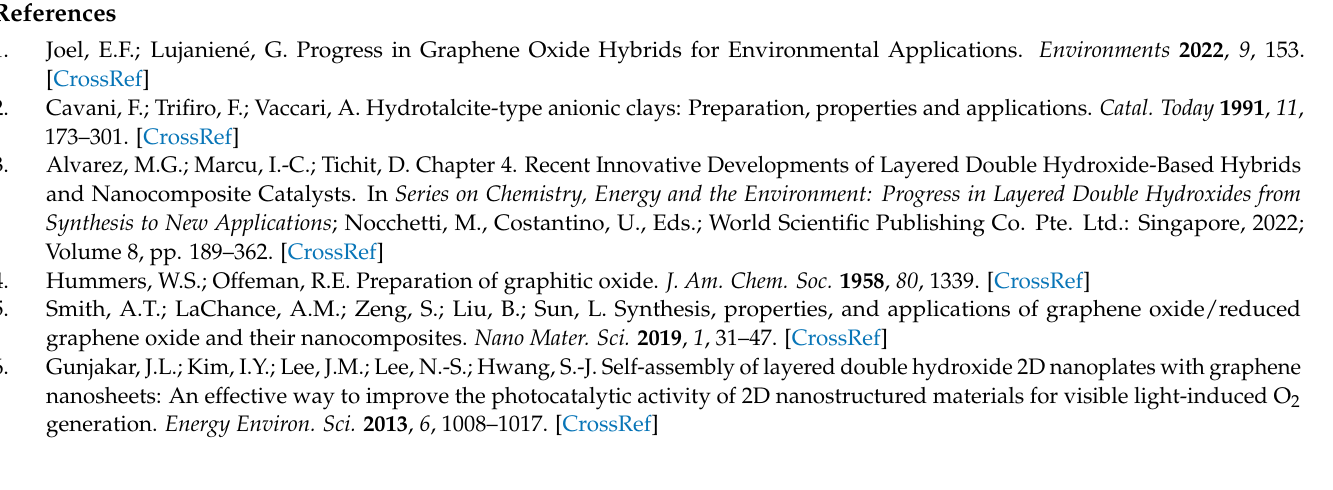
pension; Figure S1: Variation in the lattice parameters determined by XRD depending on the chemical composition of the brucite-type layer: (a) variation in a parameter, (b) variation in c parameter; Figure S2: BET isotherms of the investigated samples; Figure S3: Pore size distribution of the in- vestigated samples (BJH, Halsey–Faas correction); Figure S4: The influence of the physico-chemical characteristics of the investigated catalysts on H 2 O 2 conversion: (a) specific surface areas; (b) the proportion of mesopores; (c) the basicity expressed as the ratio between base and acid sites; (d) Mo concentration; (Reaction conditions: IC 0 = 30 × 10 − 3 M, H 2 O 2 /IC = 48 catalysts concentration 1 wt.%, 150 rpm, 2 h, 25 ◦ C); Table S1: Compositions of the solutions A and B used in the syntheses of HTMo-xGO hybrids; Table S2: The chemical oxygen demand (COD) and total organic carbon content (TOC) of the water samples after the catalytic tests performed with a concentrated solution of